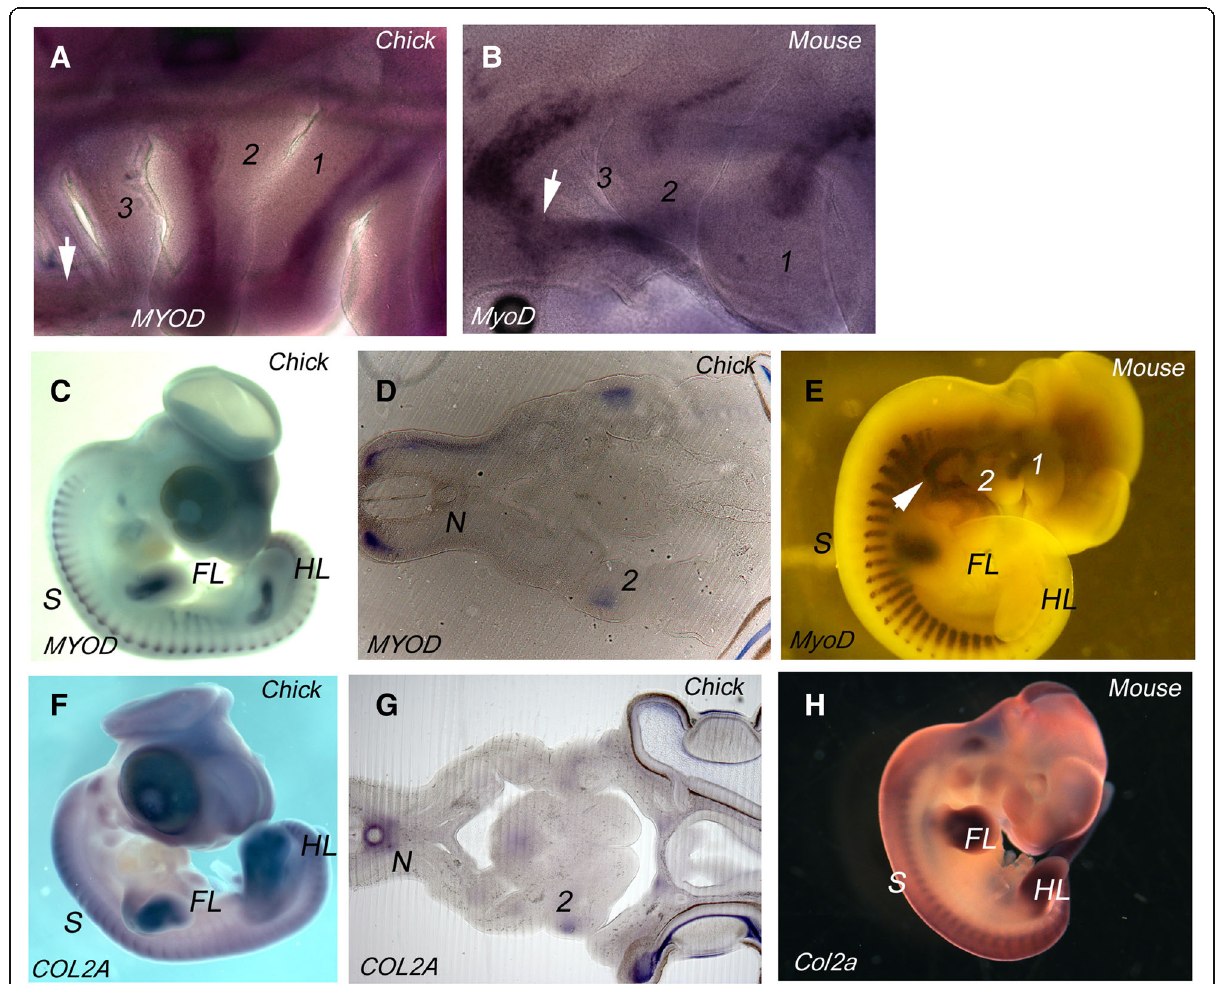
Fig. 3 Myogenesis and chondrogenesis at segmental and post-segmental pharyngeal stages ( a ) MYOD expression in a HH21 chick embryo. Myogenesis can be seen to be occurring in the first two arches but not the more posterior arches. The migratory hypoglossal myoblasts, which are somite derived can be seen to migrate through the ventral pharyngeal midline region – white arrow. b MyoD expression in a TS16 mouse embryo. Myogenesis can be seen to be occurring in the first two arches, but not the more posterior arches. The somite derived hypoglossal myoblasts can be seen to be migrating around the caudal aspect of the pharyngeal arches and along the ventral pharyngeal midline, indicated by the white arrow. c MYOD expression in chick embryo at HH25. Ongoing myogenesis can be seen to be occurring in the somites and within the limb buds. There is some myogenesis apparent in the extended second pharyngeal arch, but not in the posterior pharynx. d Longitudinal section through the pharyngeal region of a HH25 chick embryo. MYOD expression within the second arch is apparent, but there is no expression in the more posterior pharyngeal region. MYOD expression is also seen in the somites. The position of the notochord (N) is marked. e MyoD expression in mouse TS17 embryo. Myogenesis is associated with the somites, developing limb buds and anterior pharyngeal arches, but is absent from the posterior pharyngeal region, except for expression in the hypoglossal myoblasts, indicated by the white arrow. f COL2A expression in HH25 chick embryo. Ongoing chondrogenesis can be seen to be occurring in the somites and limb buds. There is some chondrogenesis apparent in the extended second pharyngeal arch but not in the posterior pharynx. g Longitudinal section through the pharyngeal region of a chick embryo at HH25. COL2A expression within the second arch is apparent, as is expression around the notochord (N) but there is no expression in the more posterior pharyngeal region. h Col2a expression in mouse TS17 embryo. Chondrogenesis is associated with the somites, developing limb buds and anterior pharyngeal arches, but is absent from the posterior pharyngeal